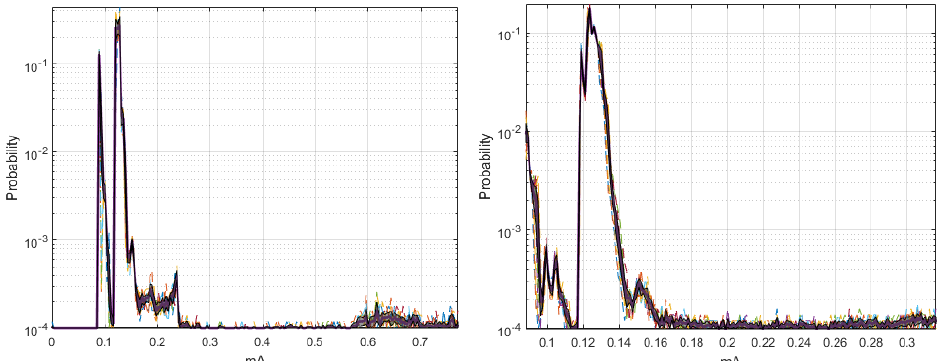
Figure 19. CIs of pdf for WiFi network: ( Left ) 9600 bauds; and ( Right ) 57,600 bauds. From top to bottom: Coordinator Node and Nodes 1–4.